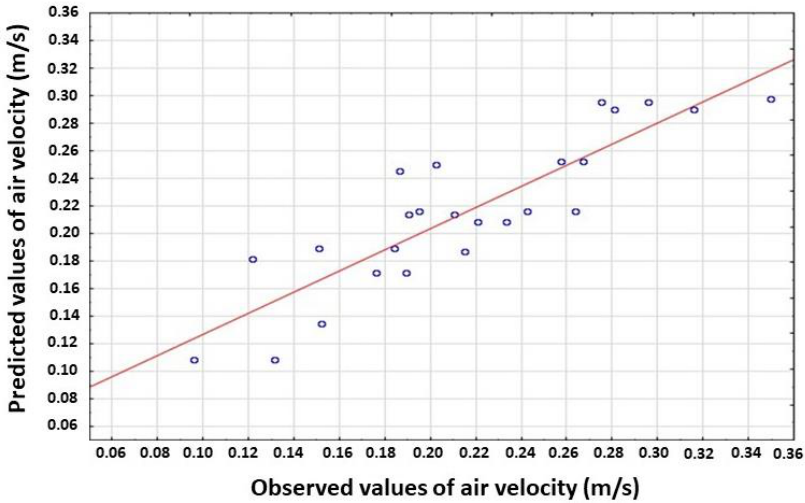
Figure 21. Predicted versus observed values of air velocity in the reaction cell with upper air inlet and outlet geometry.